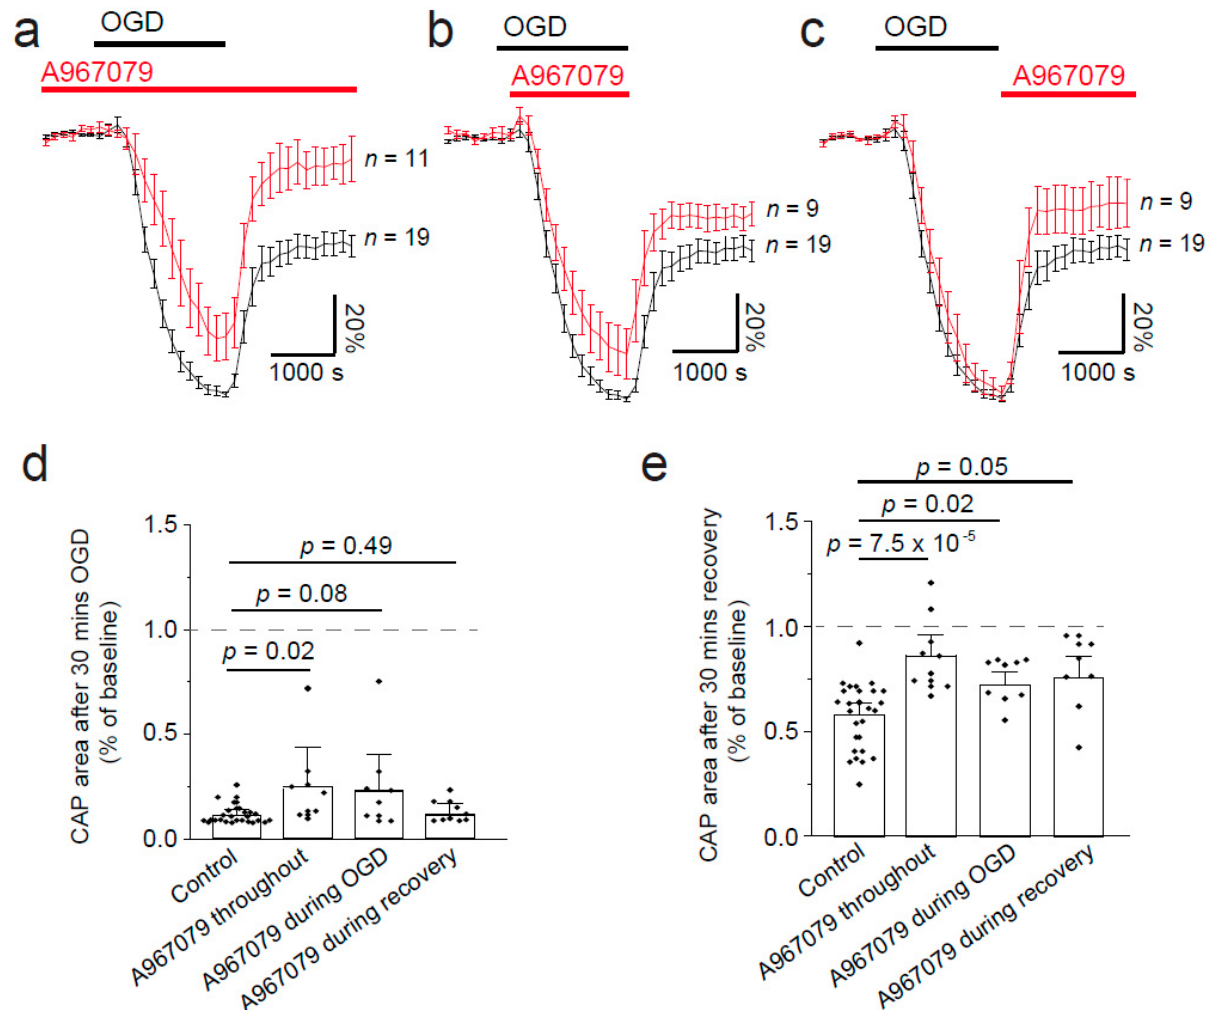
Figure 4. Ischaemia-evoked changes in optic nerve compound action potential (CAP) are reduced by TRPA1 block with A-967079. ( a ) Normalised area of CAP before, during, and after ischaemia, simulated by removing oxygen and glucose and replacing them with nitrogen and sucrose, showing how preincubation of the TRPA1 antagonist (A-967079, 20 µ M) can prevent the loss of the CAP during ischaemia and improve the recovery after replacement of oxygen and glucose. Application of A ‐ 967079 during ischaemia ( b ) or during recovery ( c ) only is also protective. ( d ) Normalised CAP area after 30 min in OGD or after 30 min recovery ( e ). p ‐ values in ( d ) are from Mann–Whitney tests with Holm–Bonferroni correction for multiple comparisons. p ‐ values in ( e ) are from a one ‐ way ANOVA with Holm–Bonferroni correction for multiple comparisons.